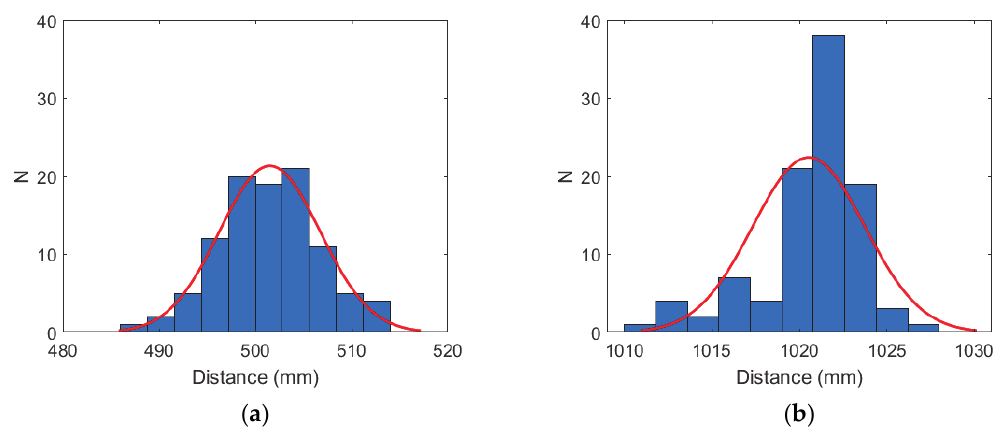
Figure 11. Test #1: Histograms for 100 laser rangefinder measurements of the distance between robot and wall. ( a ) 50 cm (test #1a) and ( b ) 100 cm (test